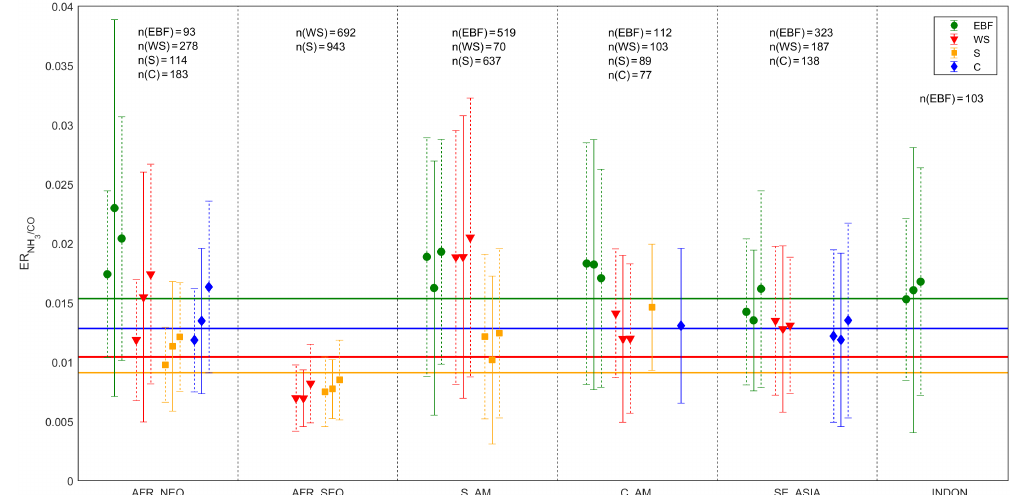
Figure 4. Mean ER NH ratios averaged for the six regions and four biomes from the yearly ER NH 3 / CO the early and late fire season ER NH ratio (left and right dashed error bars, respectively) calculated between 2008 and 2015 for the pixels 3 / CO selected in Sect. 2.3. The error bar is the 1 σ SD around the mean. The mean yearly ER NH for the six regions are indicated by the horizontal lines. n(x) (with x the biome) corresponds to the number of ER NH for each biome and region. Different symbols and colors are used for the different biomes. For the S and C biomes in the C.AM. region, no seasonal ER NH ratios are shown because of the lack of measurements. 3 / CO